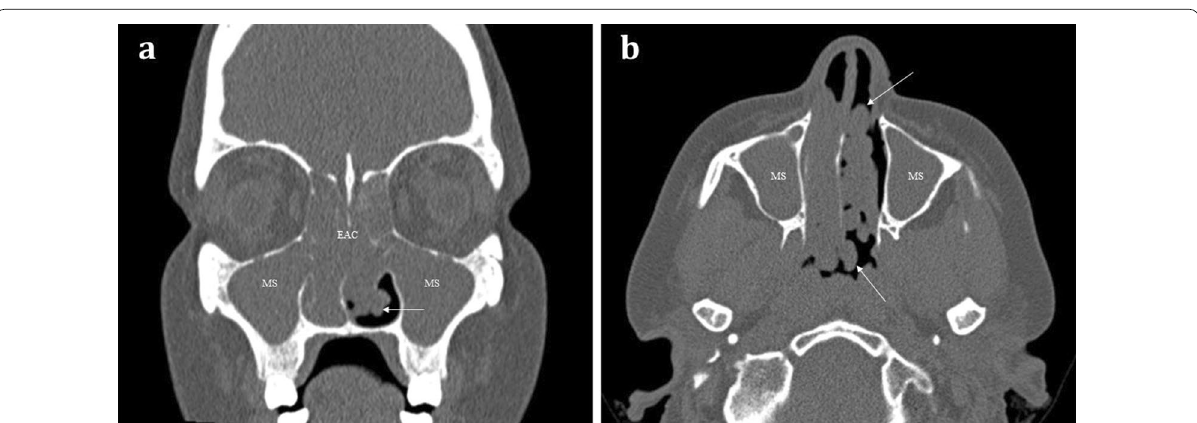
Fig. 7 48-year-old female with long standing nasal congestion and rhinorrhoea. Coronal ( a ) and axial ( b ) bone window CT images demonstrating extensive sinonasal polyposis with extension into the nasopharynx. Bilateral involvement is suggestive of benign disease. Note the characteristic rounded contours (arrows) which are very suggestive of polyposis. There is also complete opacification of the maxillary sinuses (MS) and ethmoid air cells